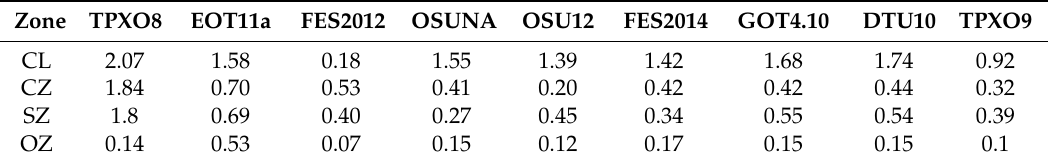
Table 3. The mean RMS values of di ff erences between the model and validation values for M 4 over di ff erent zones (cm). The smallest mean RMS is indicated by bold numbers.